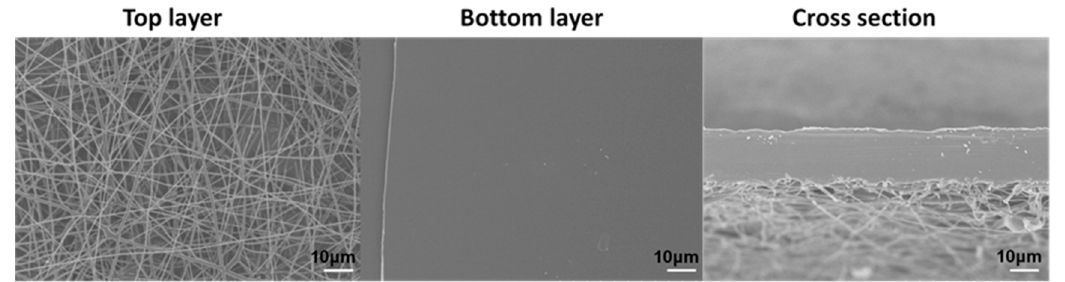
Figure 10. FE-SEM photograph for PET/PP-22% after shutdown.